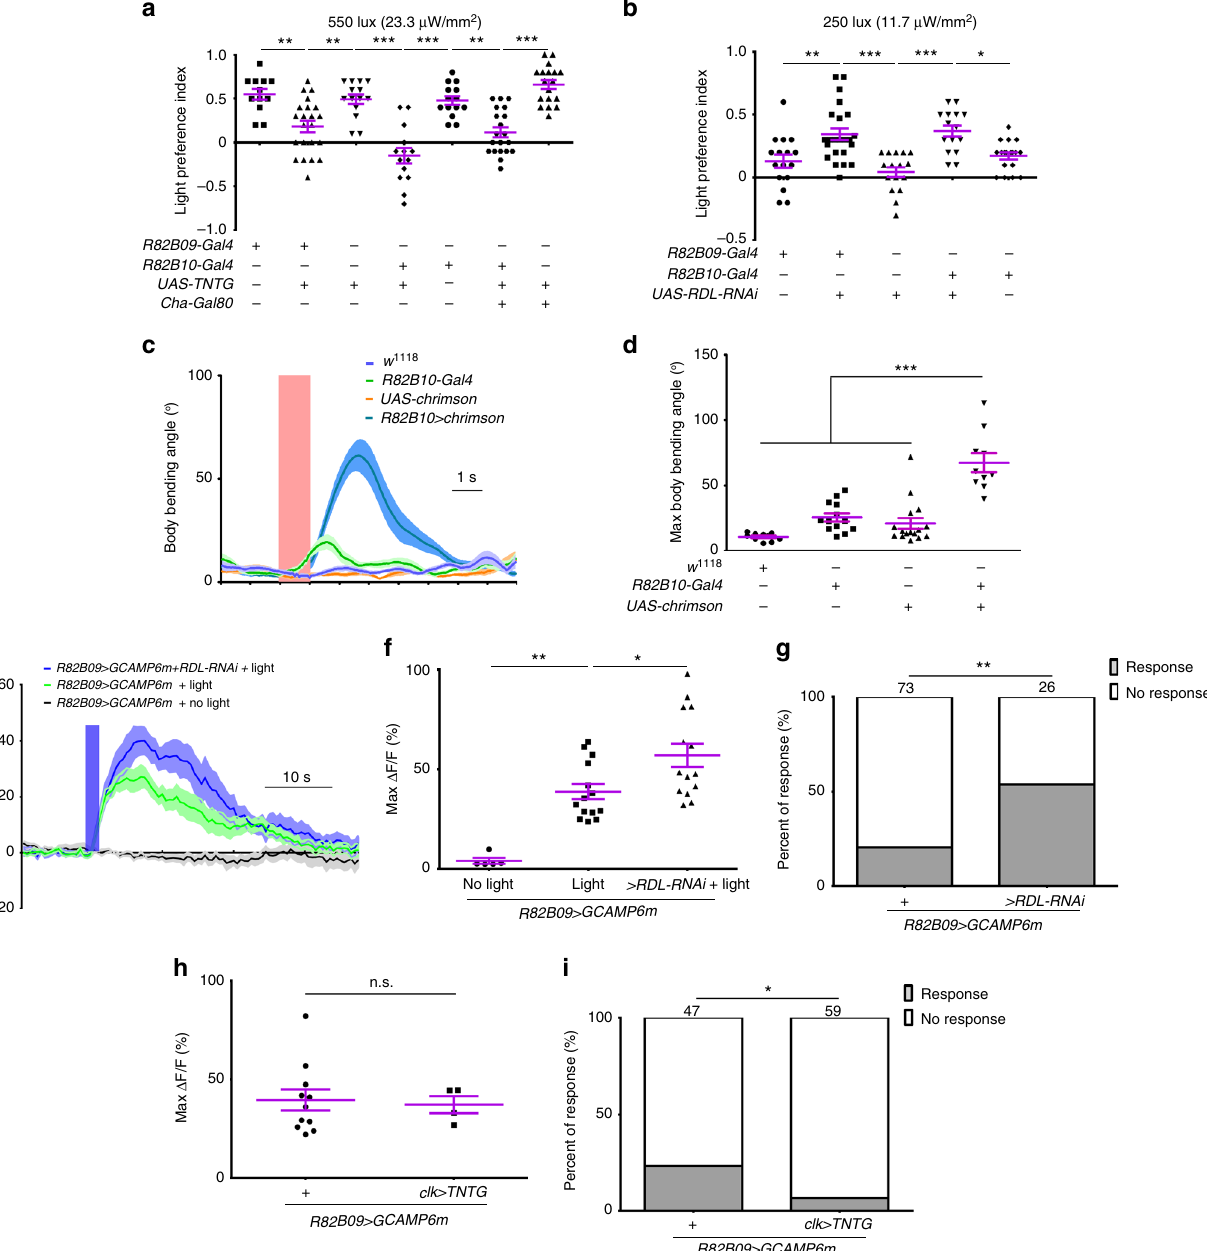
Fig. 3 The CLPN R82B09 s control head cast response to light. a Inhibiting CLPN R82B09 s abolishes larval avoidance to white light at 550 lux (23.3 μ W/mm 2 ). b Knocking down RDL expression in CLPN R82B09 s enhances larval avoidance to white light at 250 lux (11.7 μ W/mm 2 ). c – d Optogenetic stimulation of CLPN R82B09 s evokes larval head cast. d is the statistics of head cast sizes in c . The pink bar indicates the period of optogenetic stimulation. e – g Knocking down RDL expression in CLPN R82B09 s increases both amplitude and probability of CLPN R82B09 s ’ response to light in calcium imaging. The blue bar in e indicates 470 nm light stimulation at intensity of 10.58 μ W/mm 2 . f is the statistics of peak responses in e . h – i Blocking clk-LexA neurons with TNTG does not affect the amplitude ( h ), but undermines the probability of CLPN R82B09 s ’ response to light in calcium imaging ( i ). One second 470 nm light stimulation at intensity of 10.58 μ W/mm 2 was used. In e – i, R82B09>GCAMP6m is the short for UAS-GCAMP6m/ + ;R82B09-Gal4/ + . R82B09>GCAMP6m + RDL-RNAi is the short for UAS-GCAMP6m/UAS-RDL-RNAi;R82B09-Gal4/ + . clk>TNTG;R82B09>GCAMP6m is the short for clk-LexA/UAS-GCAMP6m; R82B09-Gal4/ LexAop-TNTG . Numbers above columns in g and i indicate sample sizes. n.s. not signi fi cant, * P < 0.05, ** P < 0.01, *** P < 0.001, one-way ANOVA with Tukey ’ s post hoc test in a – b , d , and f , t -test in h , fi sher ’ s exact test in g and i . Error bars, SEMs. Source data of a – i are provided as a source data fi